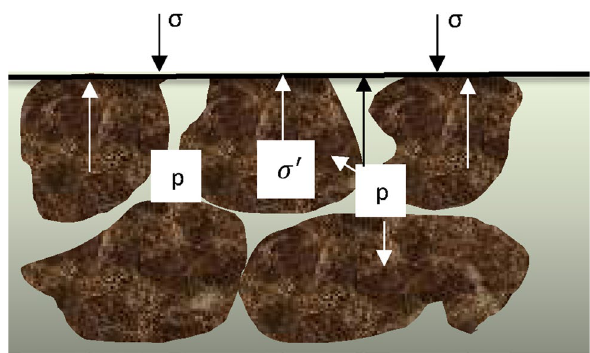
Fig. 1 Effective stress on rock grains in relationship with total stress and pore pressure